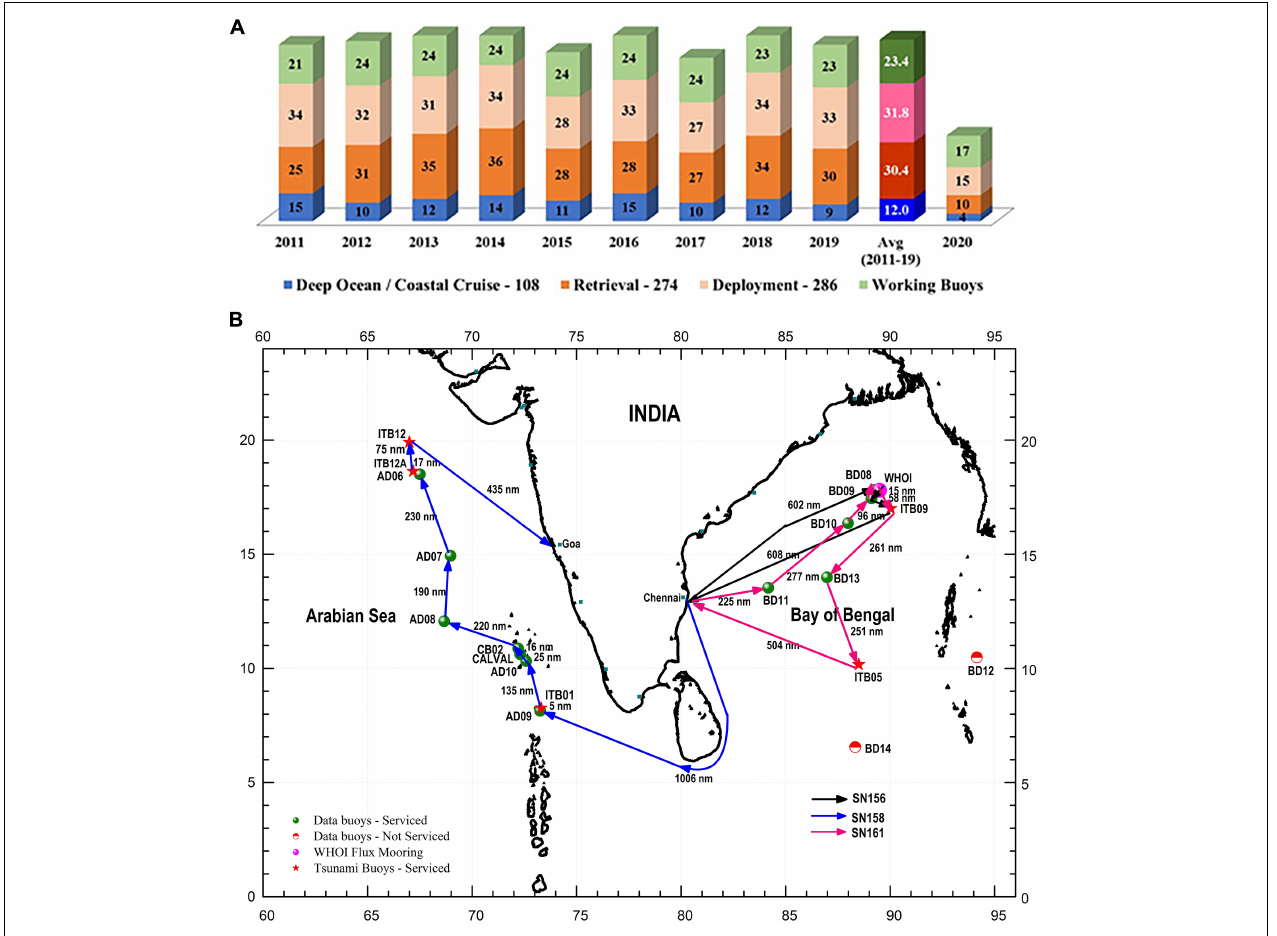
FIGURE 4 | (A) The operational statistics of the moored buoy program during the period 2011 to 2020 and (B) the tracks of the cruises undertaken to service the buoys during the COVID-19 pandemic.